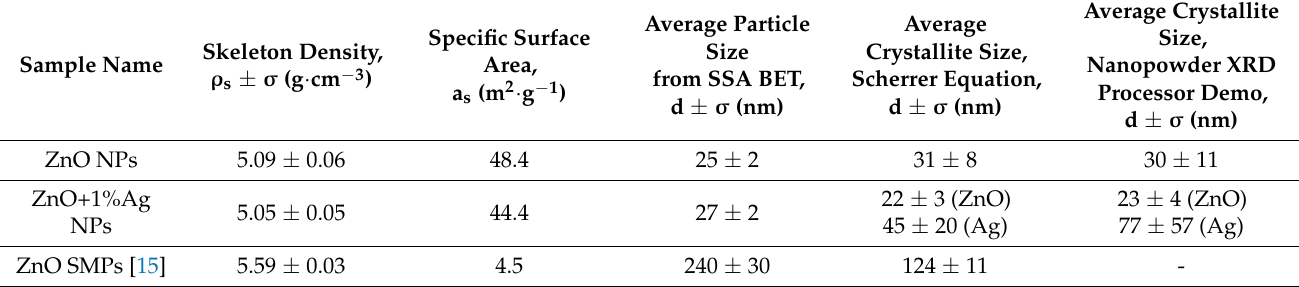
Table 1. Characteristics of ZnO samples.